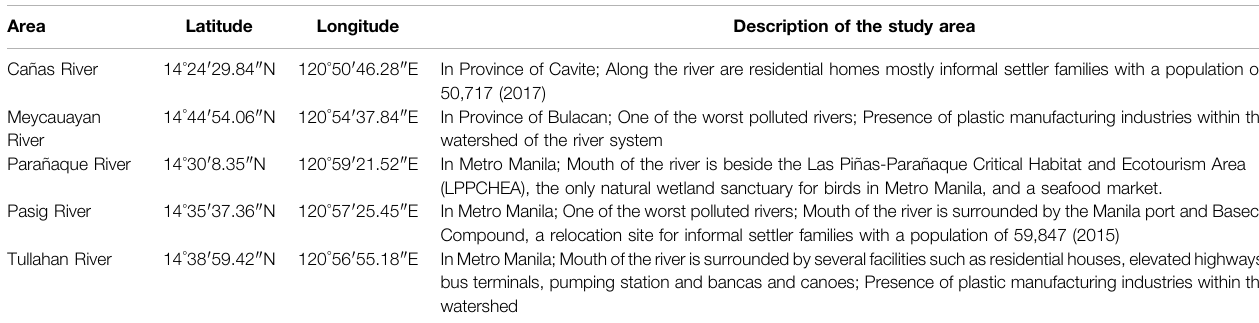
TABLE 1 | Location and description of the study areas. Area Latitude Description of the study